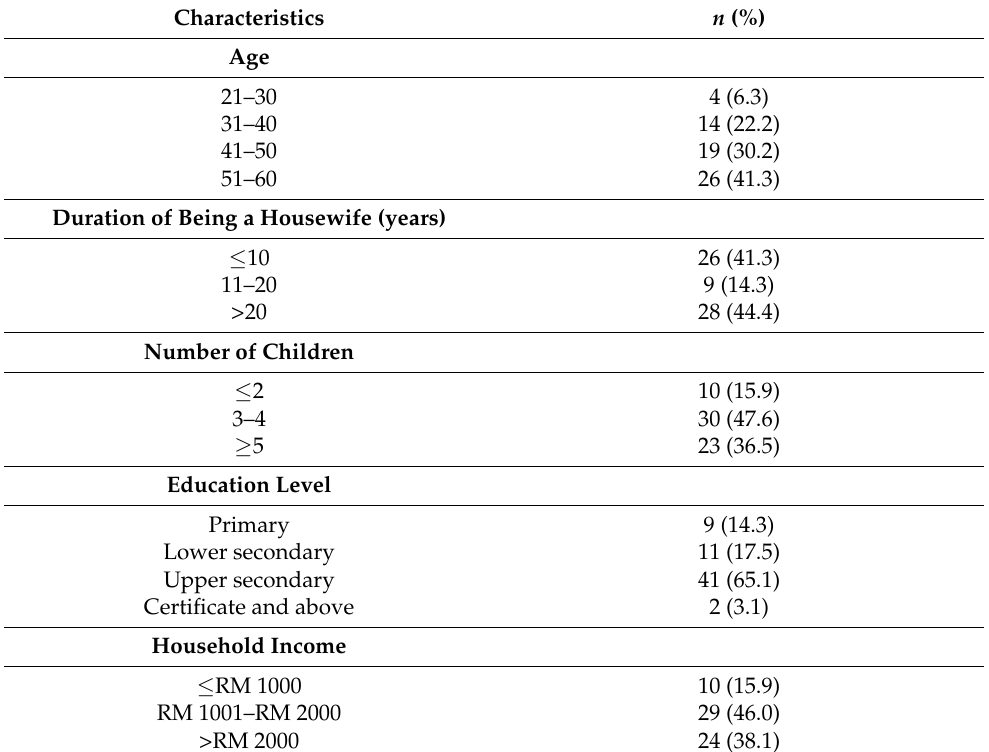
Table 1. Sociodemographic characteristic of the housewives ( n = 63).